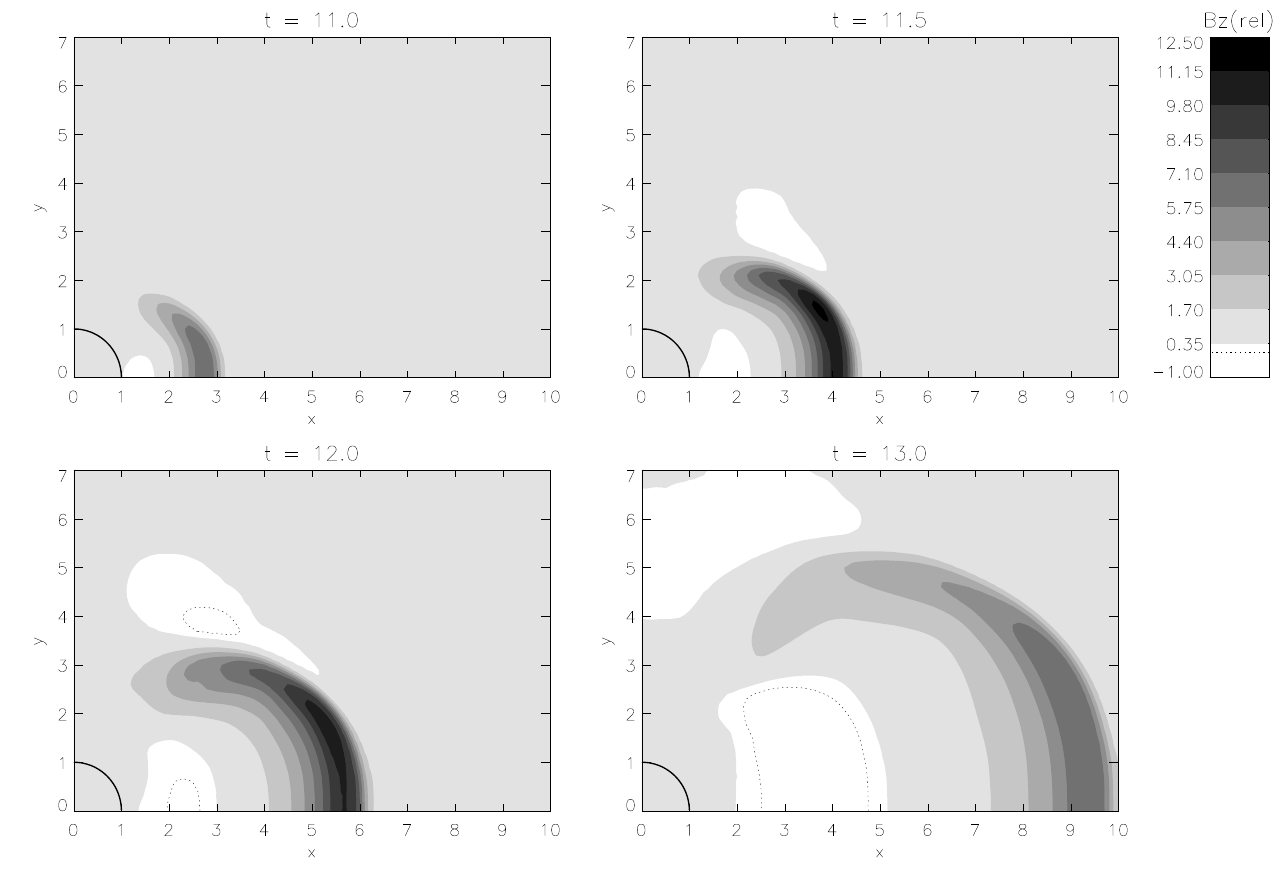
Fig. 7. Contour plot showing the value of B z in the (x,y) plane, normalized to the corresponding values at the pre-eruptive equilibrium ( t = 10 . 0). The unit circle marks the position of the solar surface. Note the field reversals occurring within the encircled regions (dotted), most notably in the CME’s